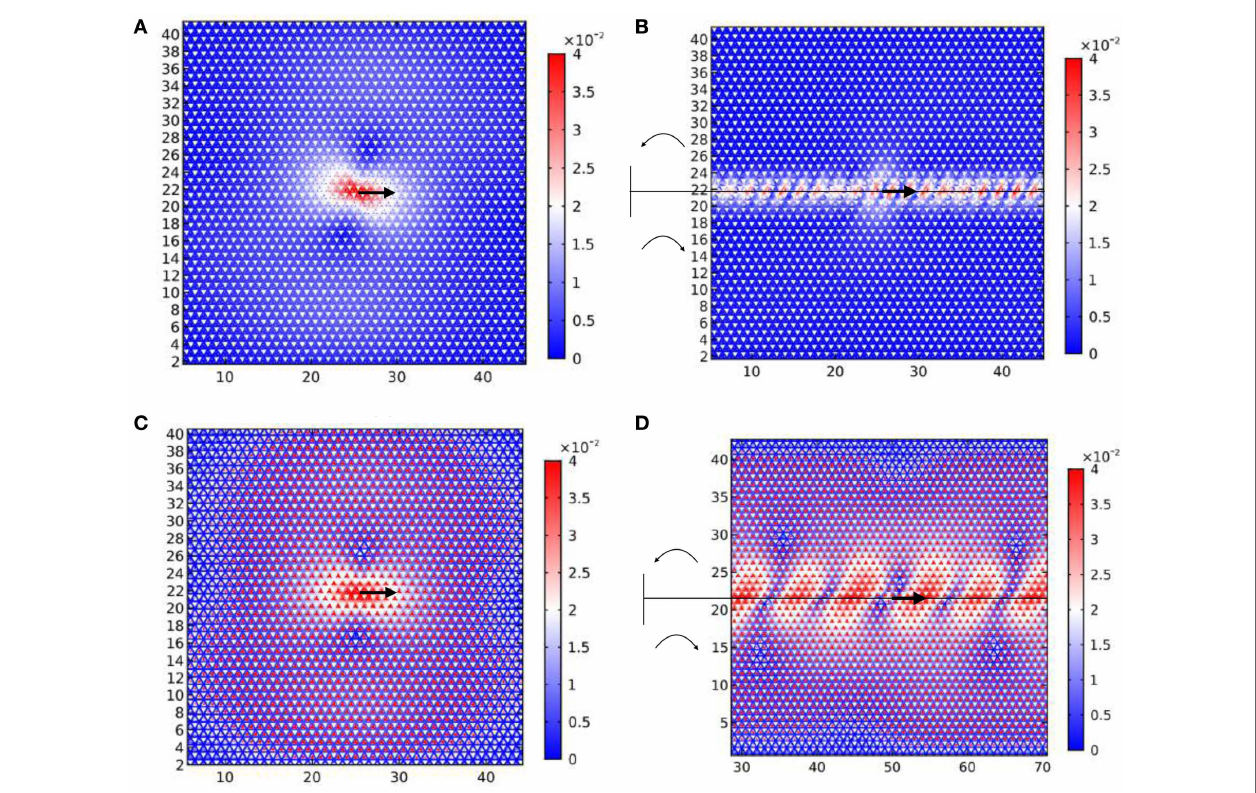
FIGURE 5 | Panels (A,C) are the responses of a homogeneously tilted cluster of resonators to a harmonic horizontal force of frequency ω = π rad/s and amplitude F = 0.1N. The lattice parameters are the same as represented in Figure 3D by the red dashed line and the blue dotted line, respectively. Panels (B,D) are the responses of a non-homogeneously tilted cluster of resonators to a harmonic horizontal force of frequency ω = π rad/s and amplitude F = 0.1N. In panels (B,D) , the tilting angle is oriented anticlockwise (clockwise) above (below) the thin horizontal line. The remaining lattice parameters, including the modulus of the tilting angle, are the same as in panels (A,C)